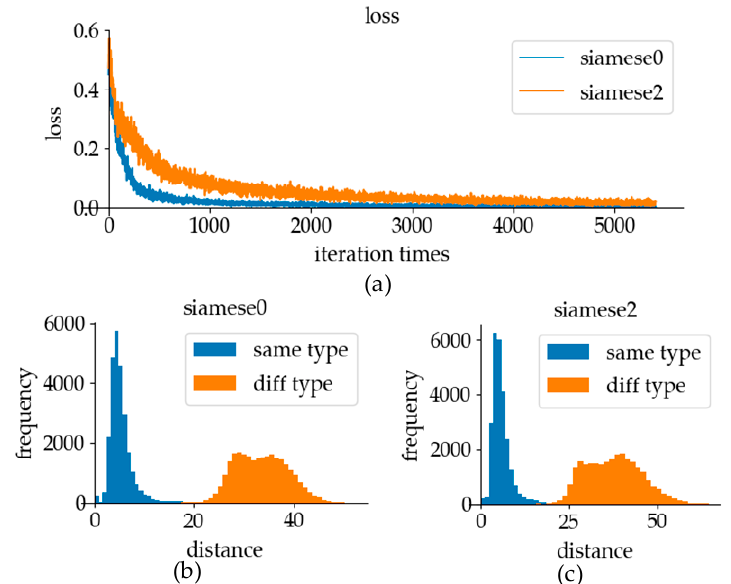
Figure 22. Comparison of experimental results with different initialization methods. Each of these subgraphs has the same meaning as Figure 21. ( a ) The siamese0 represents the situation under the normal distribution parameter initialization method used in the training process, and the siamese2 represents that under the parameters trained by the classification model for feature extraction. ( b ) The test result diagram initialized with the classification model parameters. ( c ) A test result diagram that only used normal distribution for parameter initialization.